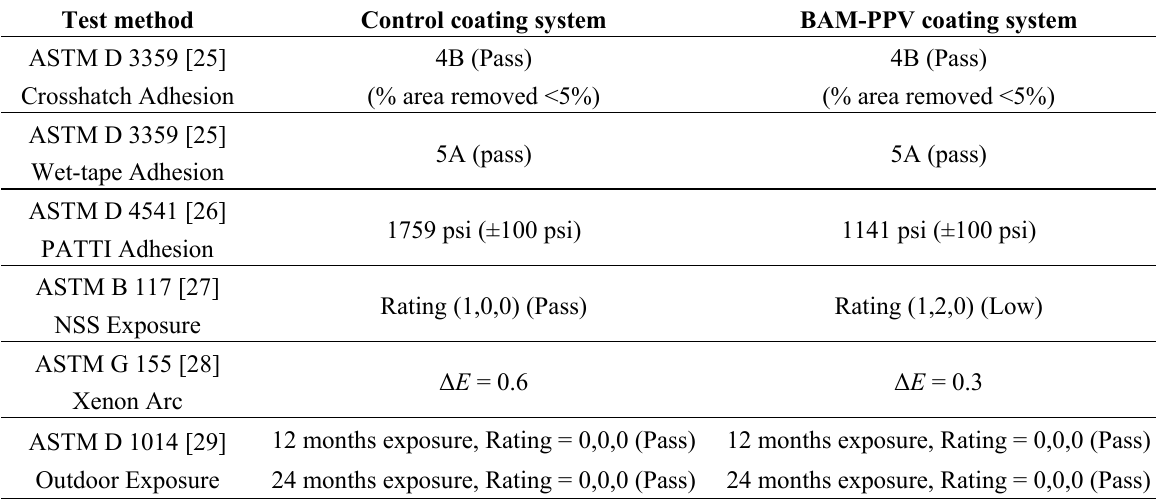
Table 1. Results from Laboratory Testing of BAM-PPV Coatings vs. Control.